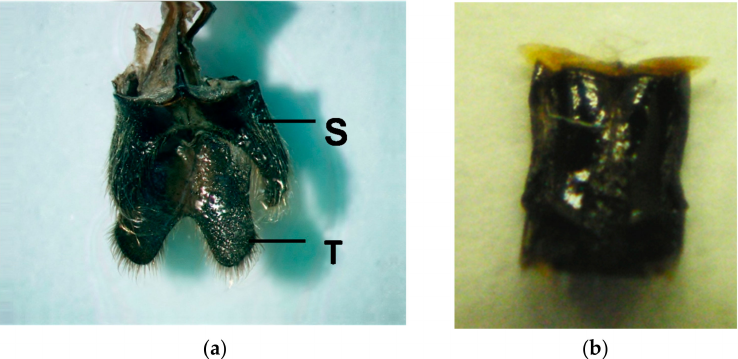
Figure 10. ( a ) The eighth abdominal tergite (T) and sternite (S) of an adult male Rosalia batesi . The tergite and sternite are membranous rather than chitinized, and are of a peculiar bifurcate shape, with numerous sensory apertures on the entire surface of the tergite. ( b ) The eighth abdominal of the adult female Rosalia batesi has a much simpler appearance.